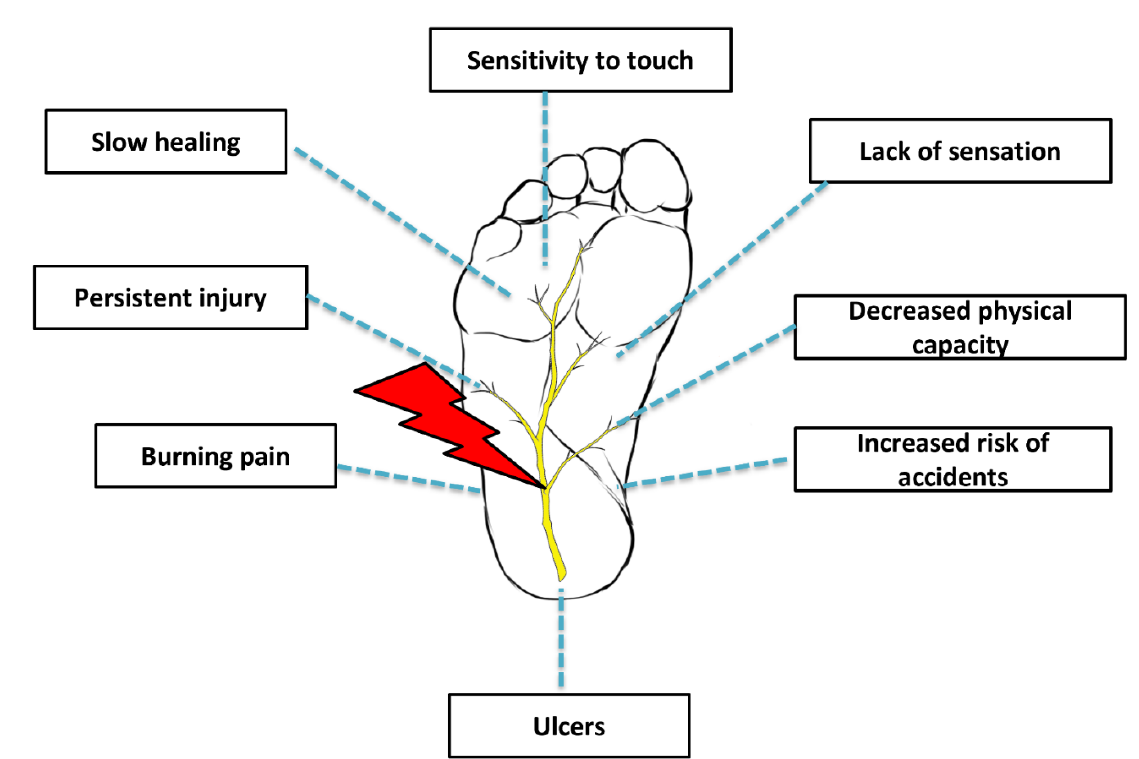
Figure 1. Diabetic peripheral neuropathy.